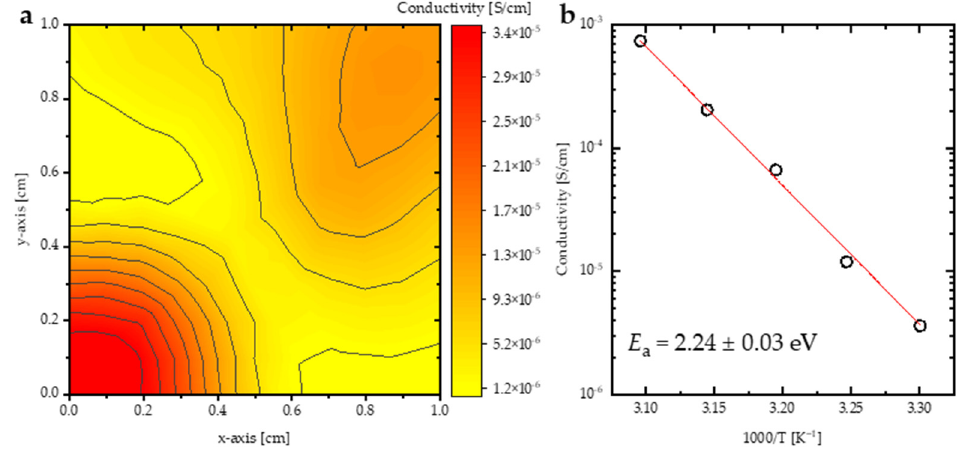
Figure 6. ( a ) The conductivity mapping (1 cm × 1 cm) of DIPAC thin film, ( b ) electrical conductivity of DIPAC films as a function of 1000/T [K − 1 ].